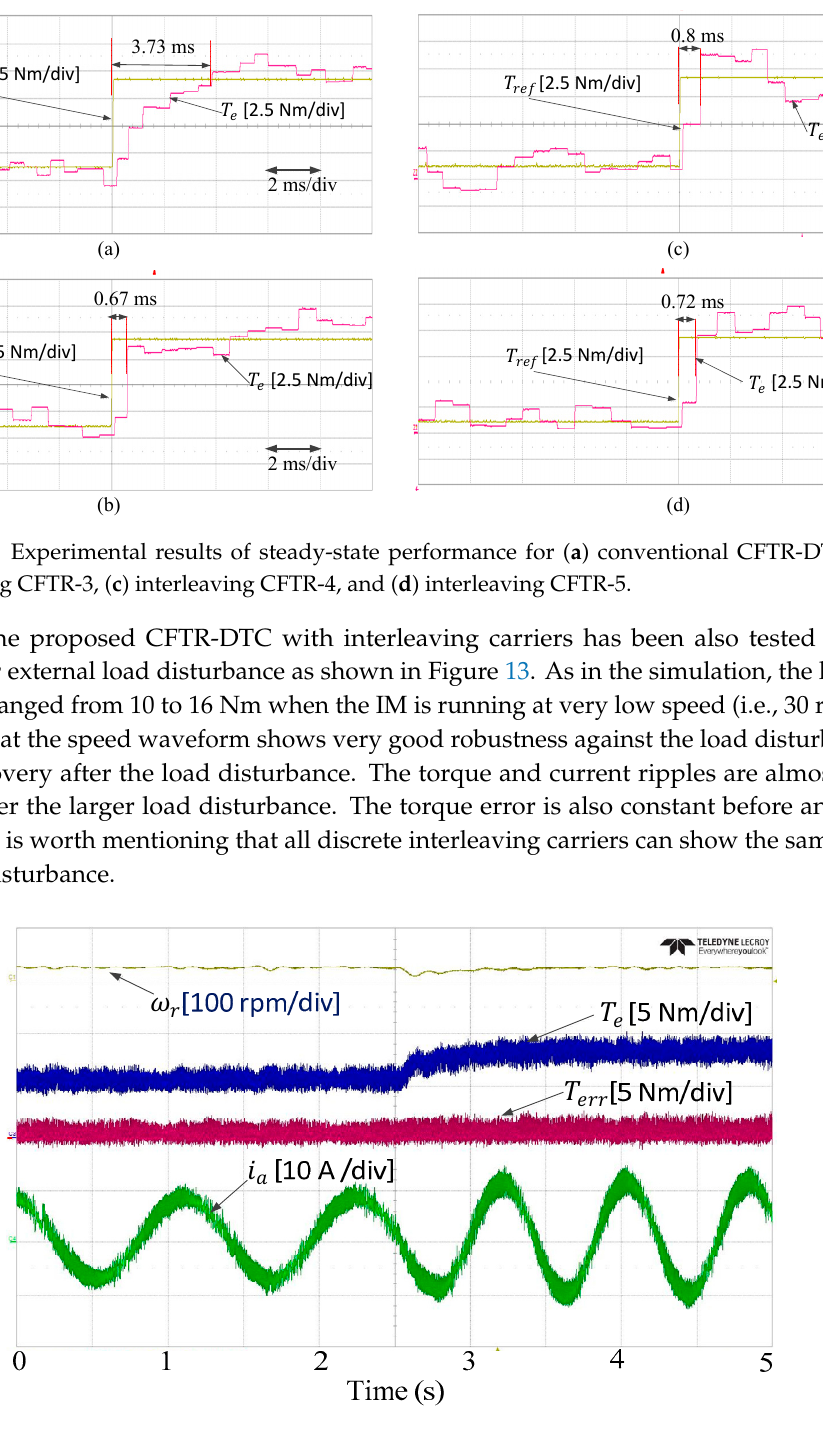
Figure 13. Experimental results of external load disturbance for the proposed CFTR-DTC with interleaving carriers at 30 rpm.